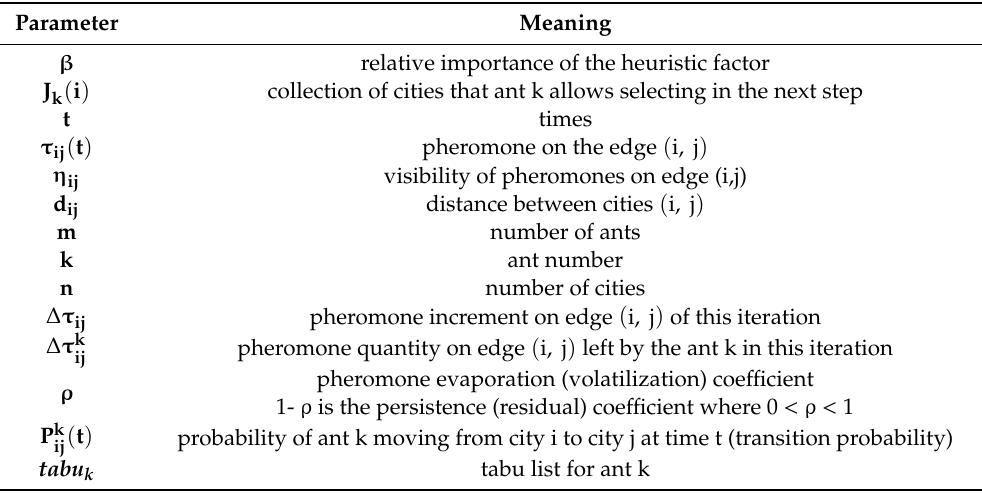
Table 2. Parameters of ACO